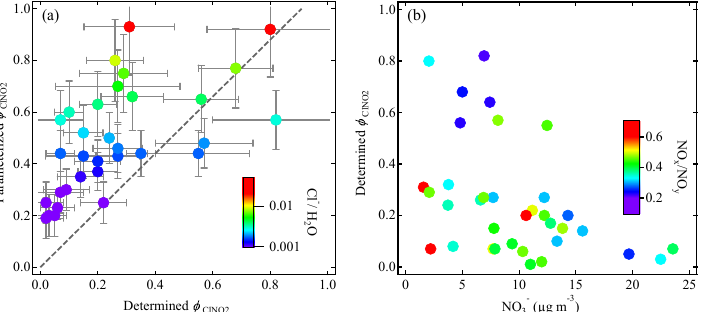
Figure 10. (a) Comparison of field-determined φ with that derived from parameterization (Eq. 7) – the colors of the markers represent the corresponding Cl − / H 2 O ratio; (b) relationship between field-determined φ and measured nitrate concentrations in aerosols – the colors of markers represent the corresponding NO x / NO y ratio. The error bars represent the total aggregate uncertainty similar to Fig.